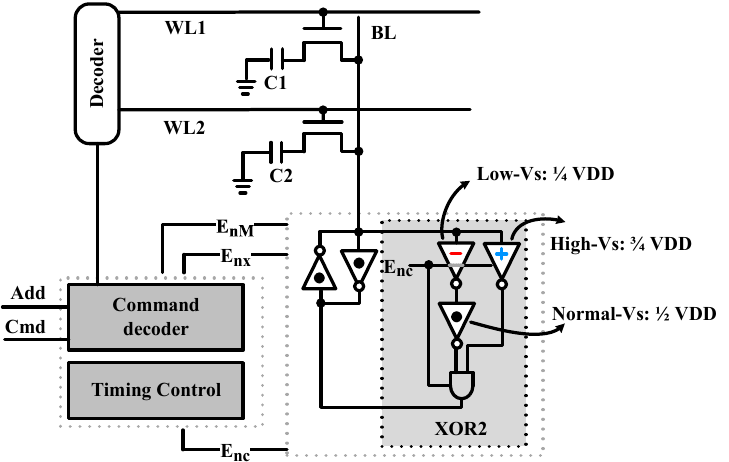
Figure 2. The reconfigurable sense amplifier is used to implement logic operations. Reprinted with permission from ref. [26]. Copyright @ 2019 IEEE.